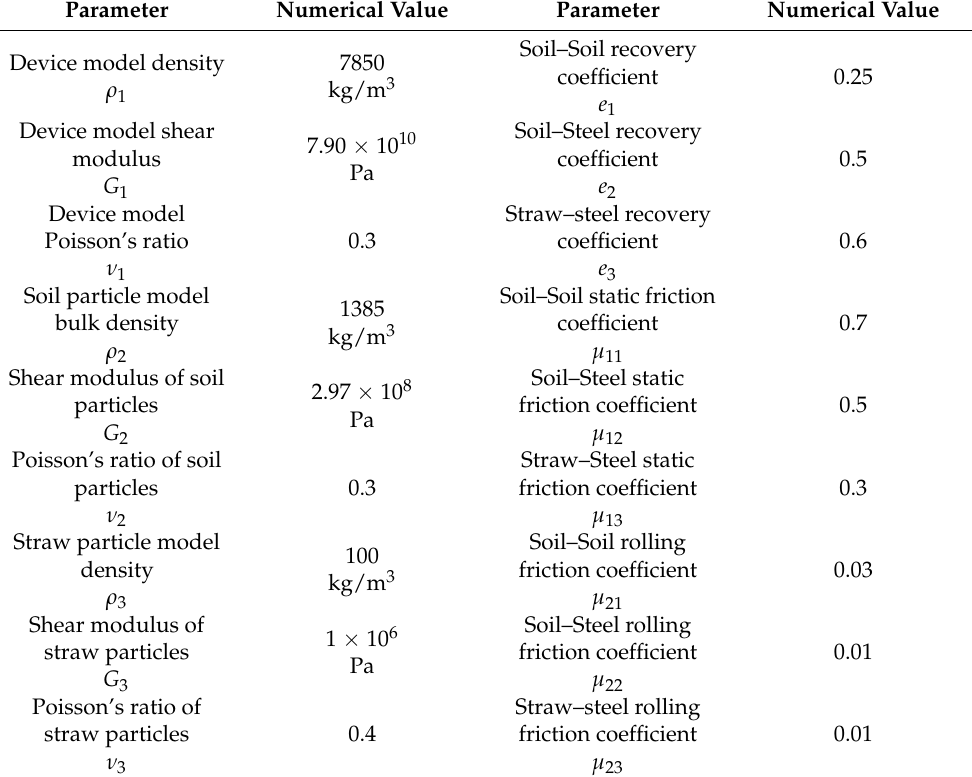
Table 2. Simulation parameters.